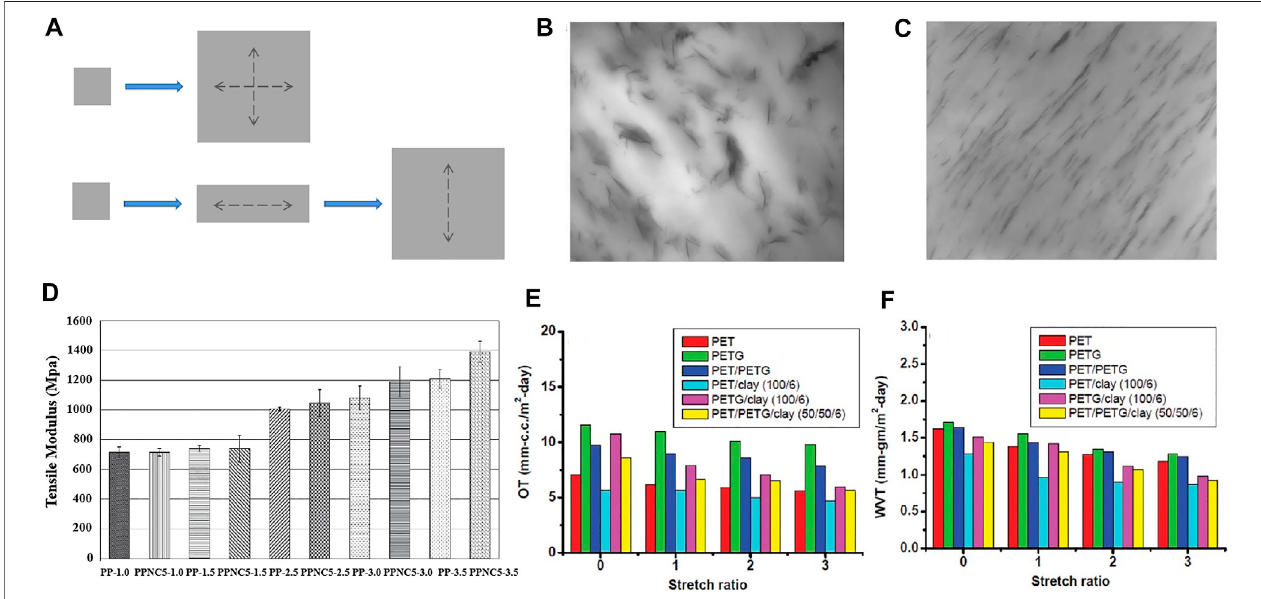
FIGURE1|(A) Schematicofbiaxialstretchingmodes(SR (cid:1) 3).TEMimages: (B) unstretchedsheet, (C) stretchedsheet(SR (cid:1) 3),magni fi cation (cid:1) 28,500,scale bar (cid:1) 500 nm. (D) Tensile modulus of PP/clay nanocomposites (Abu-Zurayk et al., 2009). Effect of SR on (E) oxygen transmission rate and (F) water vapor transmission rate of biaxially stretched PET/clay, PETG/clay, and PET/PETG/clay nanocomposites (Wu et al., 2015).